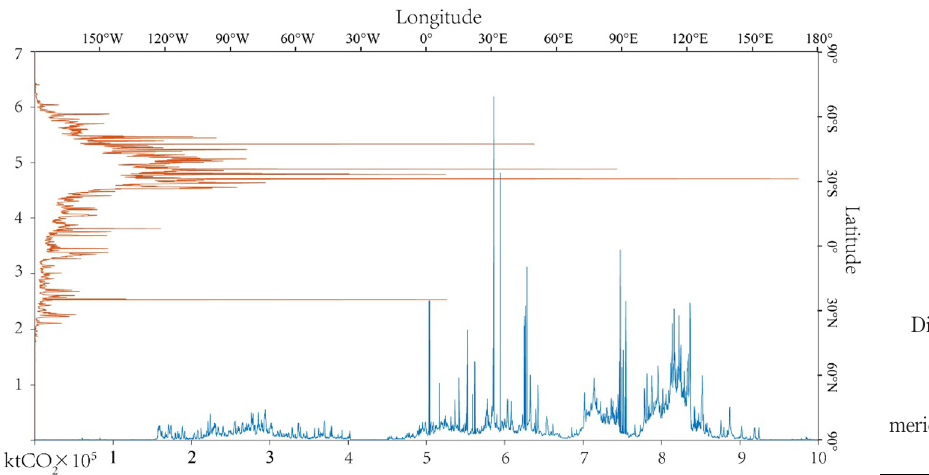
Figure 9. Distribution of the sum of the grid carbon emission values along the meridional and zonal